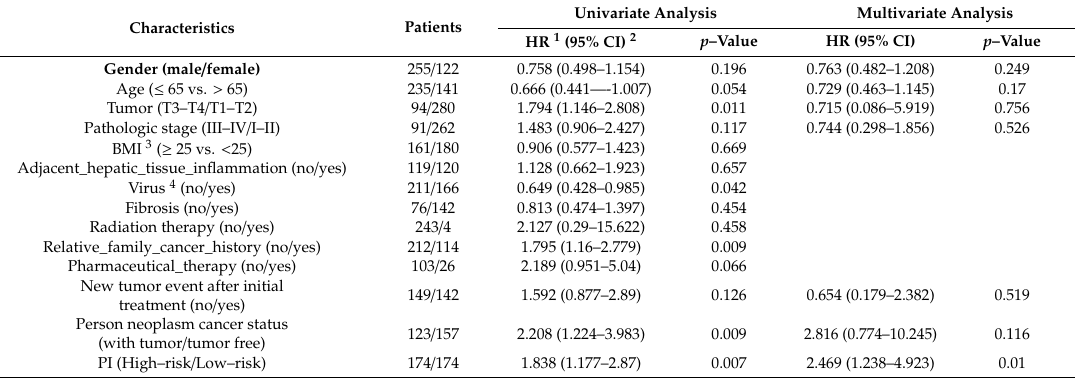
Table 3. Univariate and multivariate Cox regression analysis of characteristics and prognosis index in HCC.